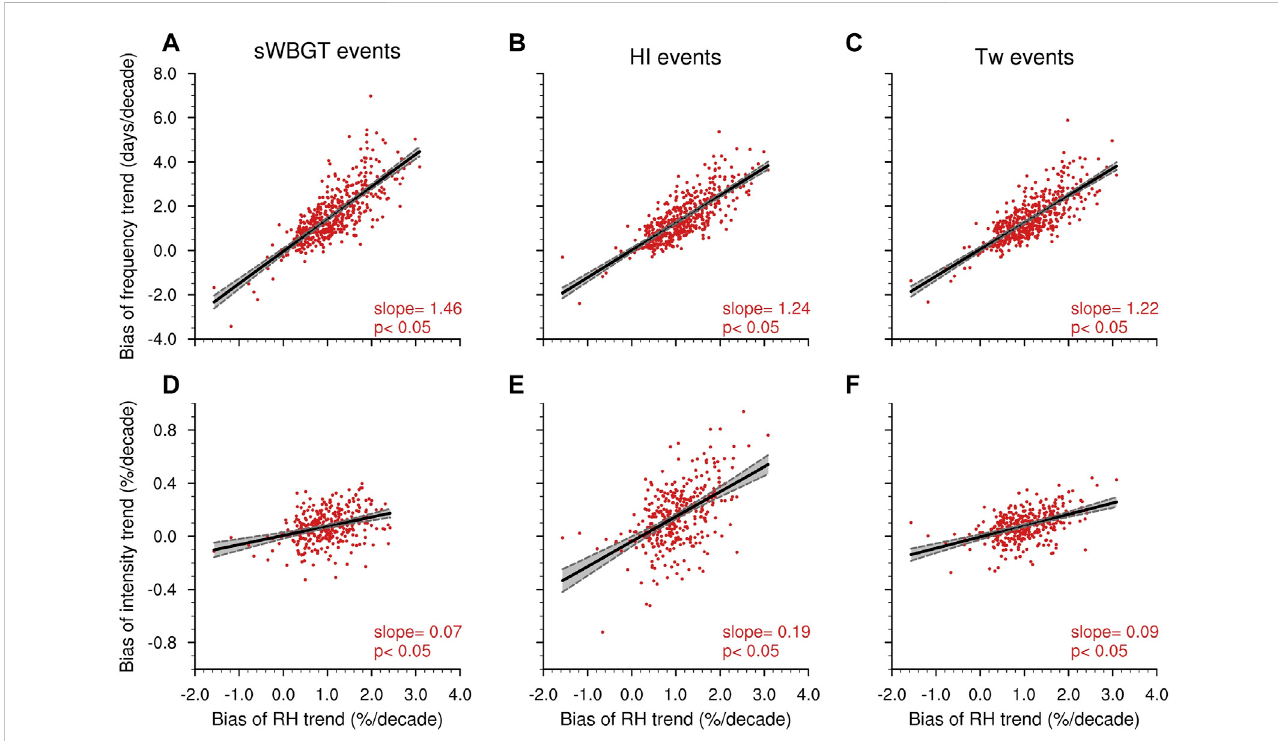
FIGURE 3 In fl uences of local RH trend bias (homogenized OBS1 minus non-homogenized OBS3) on the estimate for trends for frequency (A – C) and intensity (D – F) of humid-heat extremes across southeast China, identi fi ed using three indicators. To improve comparability in intensity amongst indicators (D – F) , the trend for intensity at each station is normalized by local indicator climatology. Linear regressions are shown by black curves and the 95% regression con fi dence intervals are shaded in grey, with regression coef fi cients (Slope) and signi fi cance (P) indicated at the lower-right of each